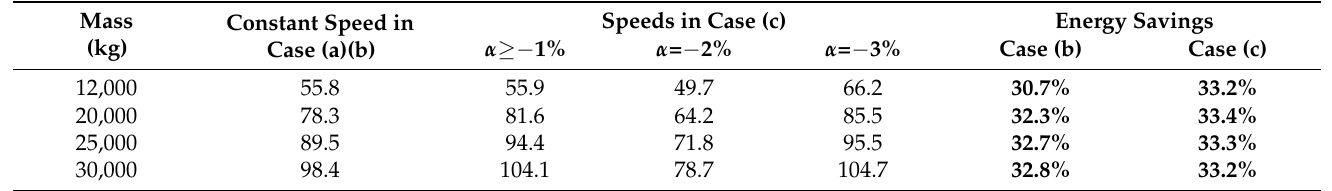
Table 4. Speeds (mph) and relative energy savings of four types of trucks in three cases without regenerative